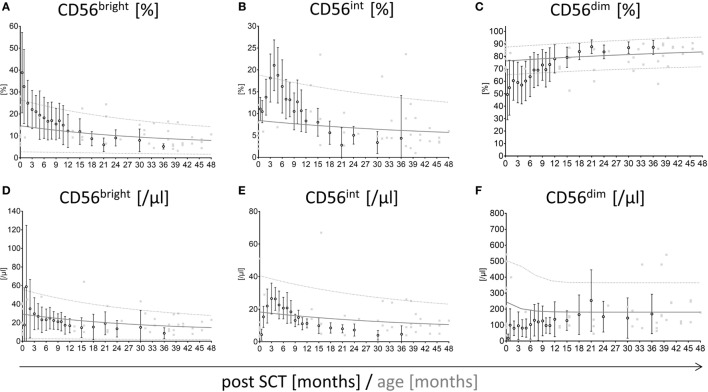
Reconstitution of CD56bright, CD56int, and CD56dim natural killer (NK) cells with respect to reference percentiles of healthy children. Reconstitution of CD56bright, CD56int, and CD56dim NK cells plotted into a graph showing the 10th, 90th (…., dotted line), and 50th (, solid line) percentile of NK cell reference values of healthy children (n = 174) as well as their underlying measurements (, gray squares). Measurements of stem cell transplanted patients without graft-versus-host disease or viral infections (n = 23; mean with SD) were plotted into the reference model (○, black rimmed circles) at 19 time points until 36 months after hematopoietic stem cell transplantation (HSCT). Time points were 15 days, 1, 2, 3, 4, 5, 6, 7, 8, 9, 10, 11, 12, 15, 18, 21, 14, 30, and 36 months after SCT. The CD56bright and CD56dim NK cells post-HSCT needed around 12 months to reach the distribution of healthy individuals NK cells. At that time point, the CD56bright, CD56int, and CD56dim NK cells met the 50th percentile of the reference range (A–C). CD56bright NK cells were elevated post-HSCT but already reached the reference range after 2 months (A). Intermediate NK cells matched the reference range directly after HSCT but showed a fast proliferation until 5 months followed by a decline until 12 months post-HSCT (B). CD56dim NK cells were underrepresented directly after HSCT, reaching the lower reference range after 8 months post-HSCT (C). The development of absolute cell counts of CD56bright, CD56int, and CD56dim NK cells is shown in subfigures (D–F).